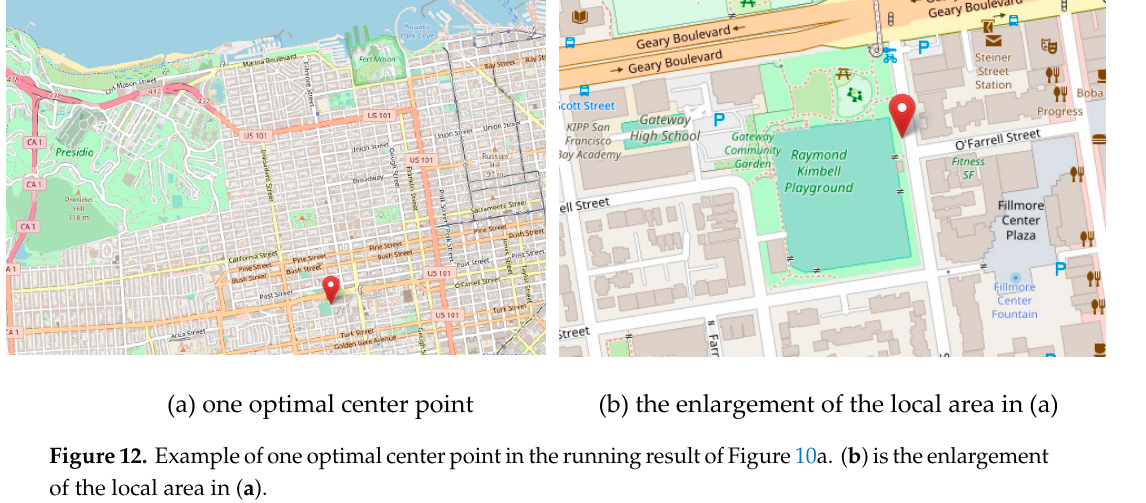
18 of 21 Figure 11. The time-sequential coloring graph of optimal stay centers. The DBSCAN clustering method is used for datasets DS1 – DS4 . As can be seen from Figures 10 and 11, every Monday, taxis in San Francisco appear more